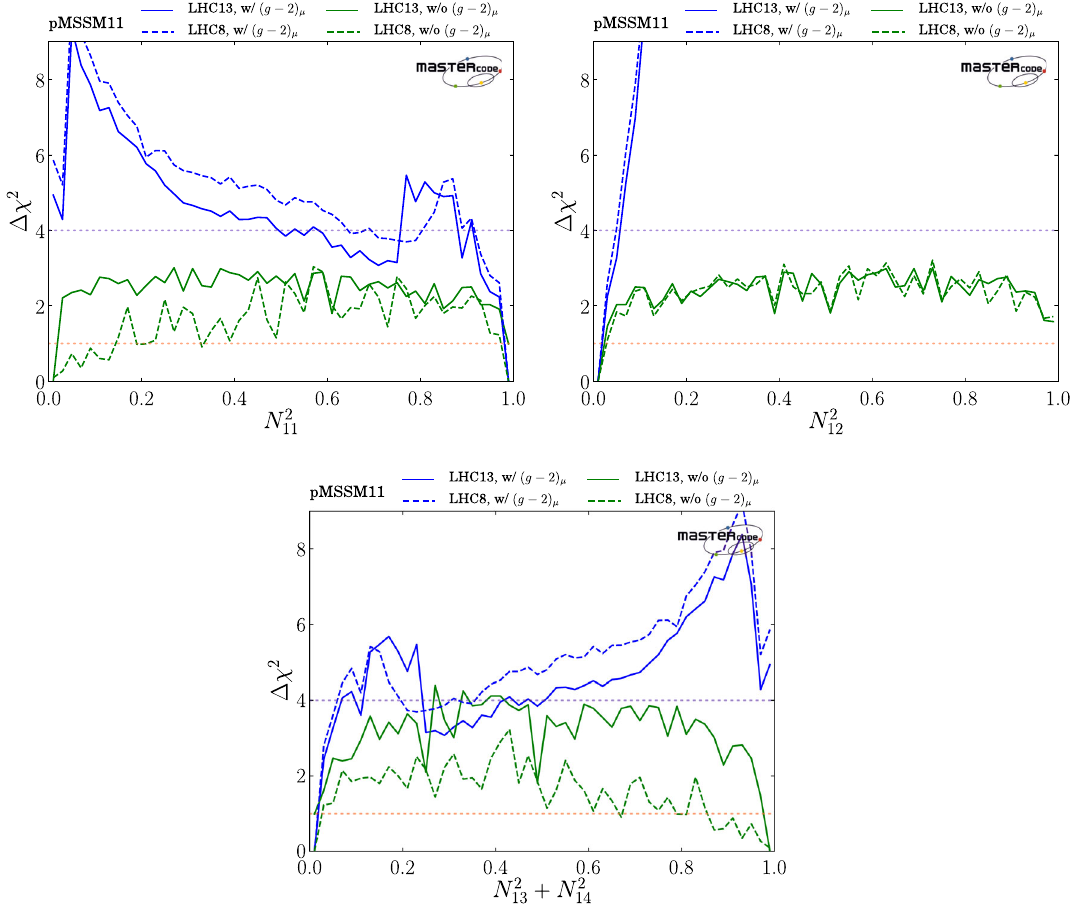
composition in the (upper left), for the ˜ W 3 fraction (upper right) and 1